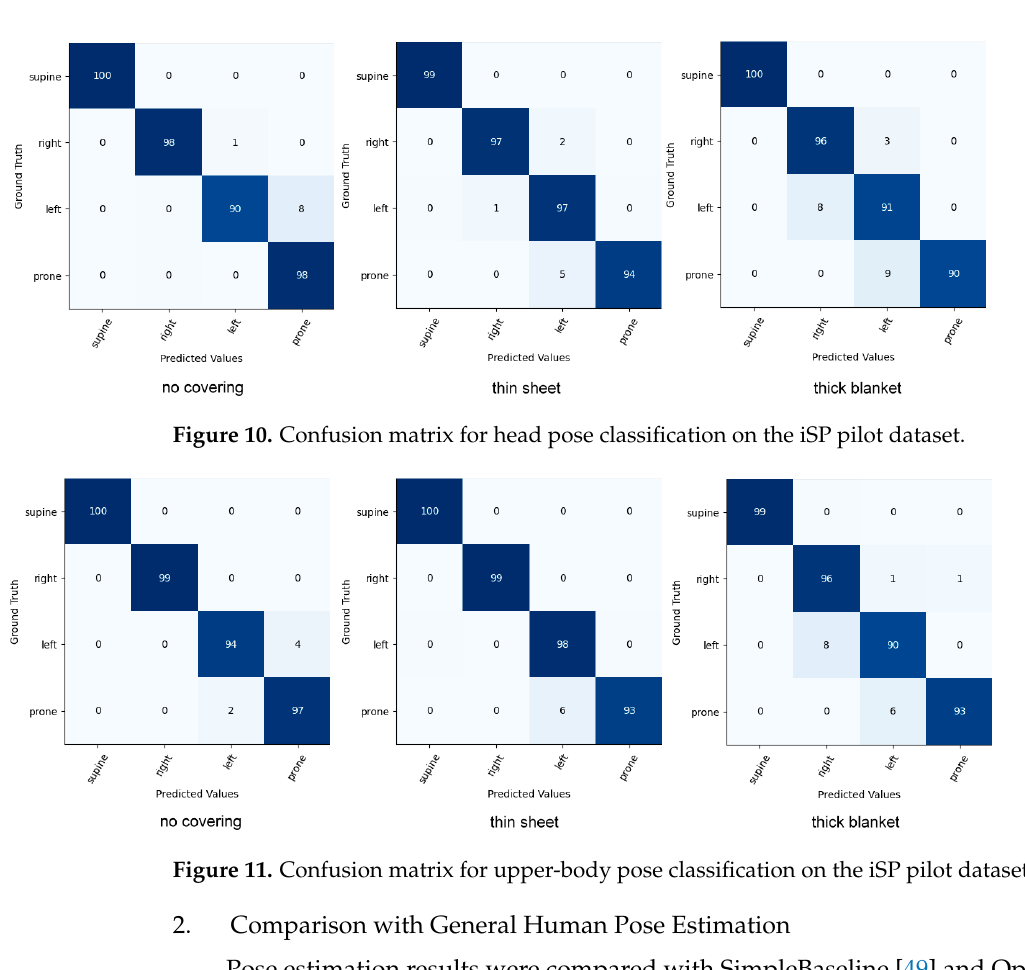
Figure 11. Confusion matrix for upper-body pose classification on the iSP pilot dataset.